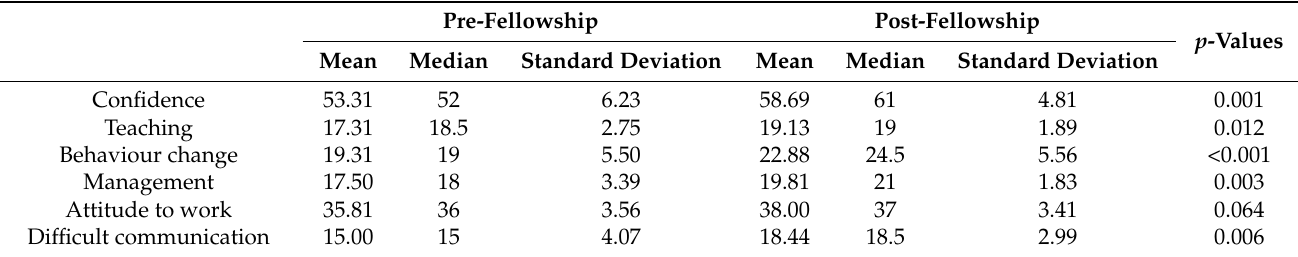
Table 1. Summary statistics for cumulative Likert-rated responses for the components of MOVE-iT.